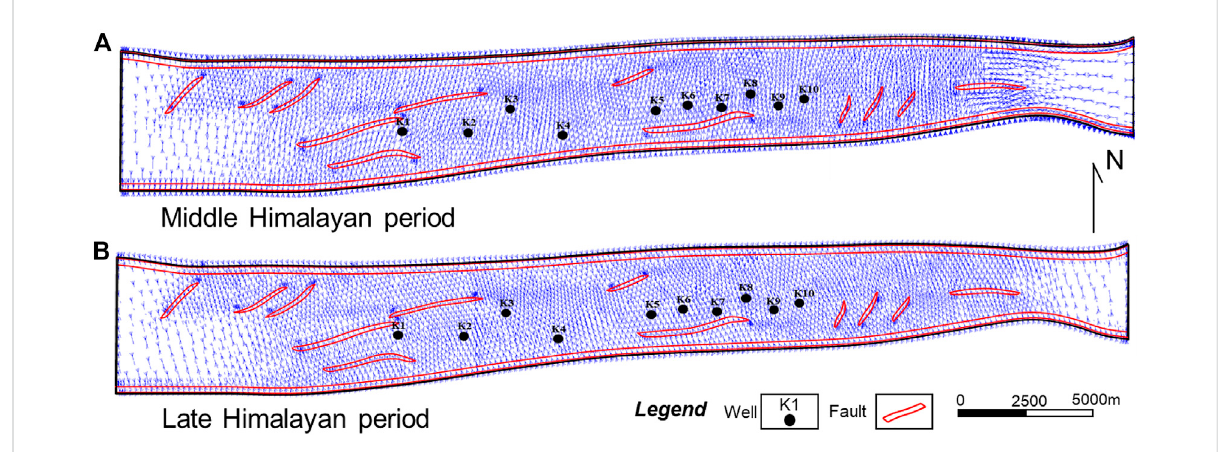
FIGURE 11 Distributioncharacteristicsofmaximumprincipalstressdirectionoftectonicstress fi eldindifferentperiods. (A) Directionofmaximumprincipal stress in middle Himalayan period of target layer; (B) Direction of maximum principal stress in late Himalayan period of target